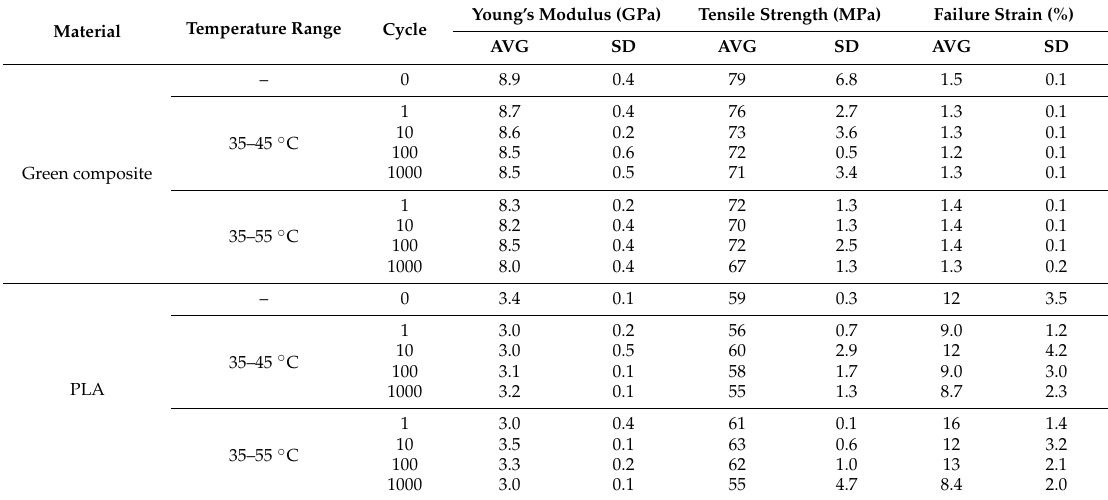
Table 1. Tensile test results of green composite and PLA (AVG: average value, SD: standard division). Material